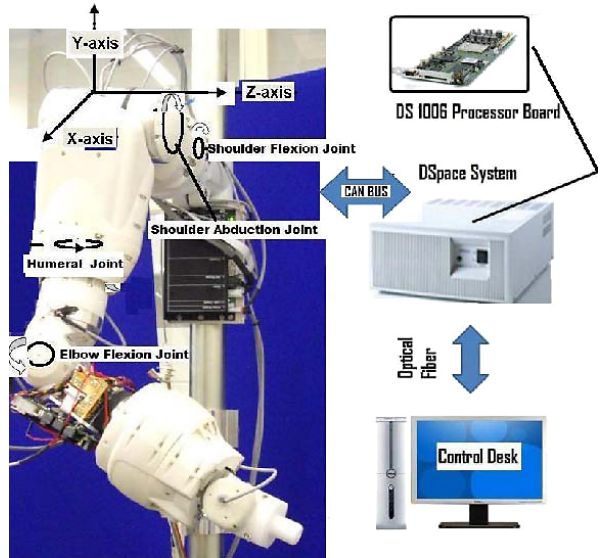
Figure 4. Experimental setup using dSPACE.